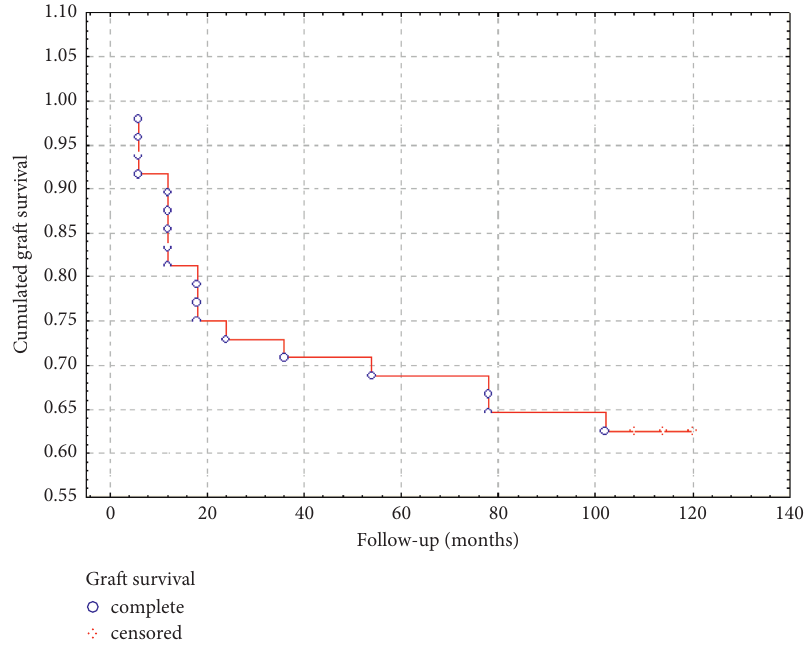
Figure 1: Kaplan–Mayer curve showing graft survival